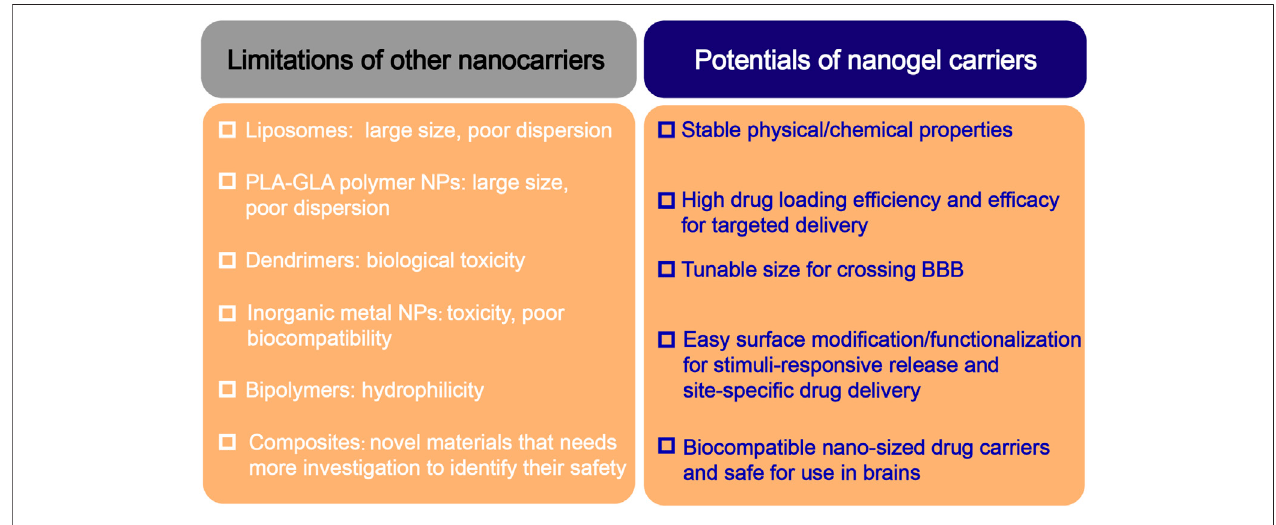
FIGURE 3 | Potentials of nanogels for CNS drug delivery compared with other available nanocarriers.